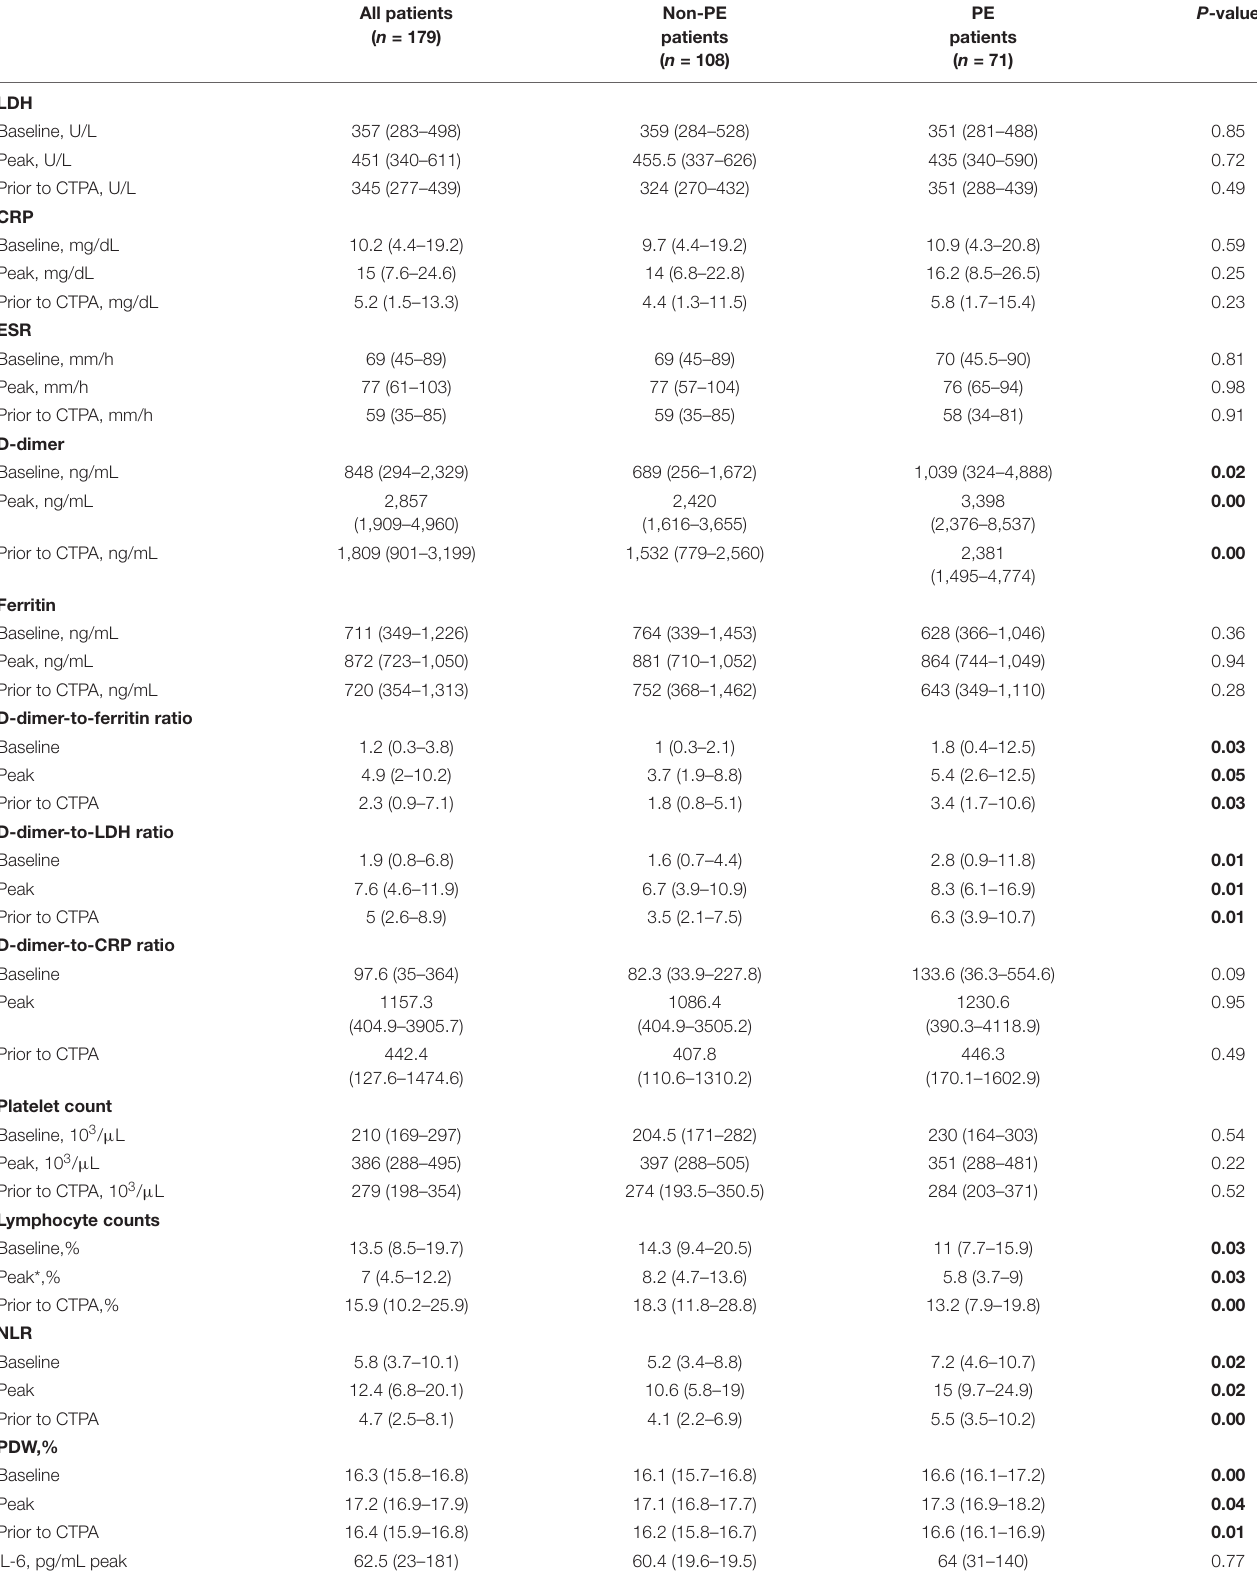
TABLE 3 | Inflammatory profile and pulmonary embolism biomarkers of patients admitted because of COVID-19 pneumonia with and without pulmonary embolism. All patients Non-PE ( n = 179)